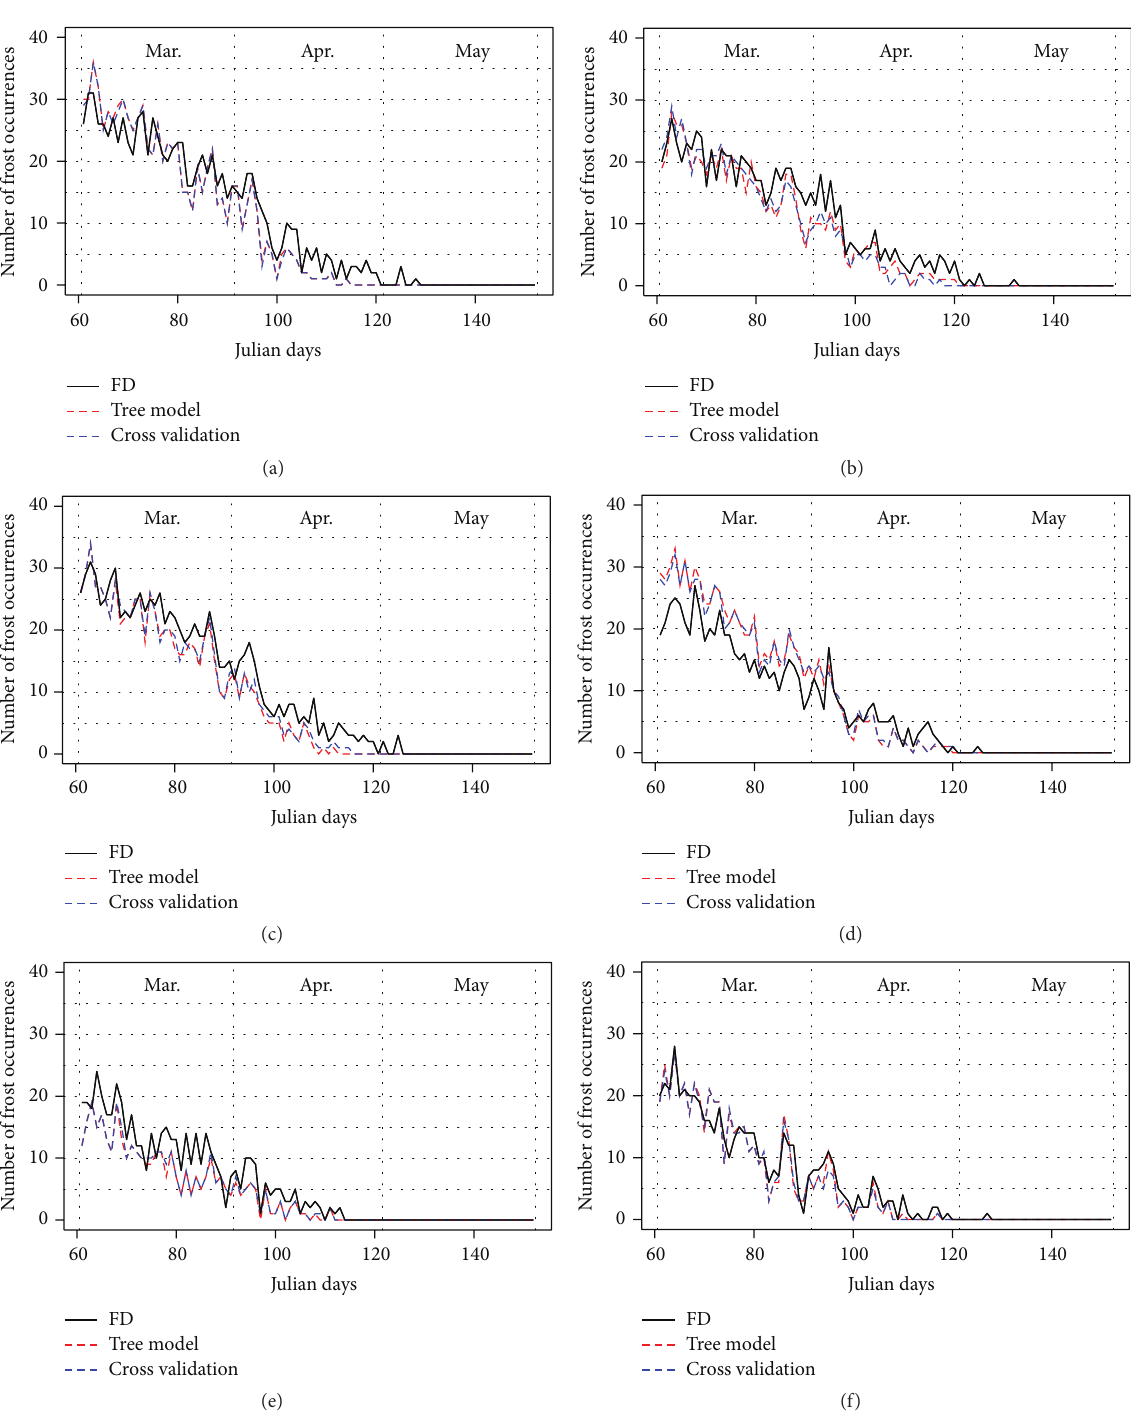
to prevent frost damages to agricultural crops by providing timely interventions for frost damages to agricultural farms and